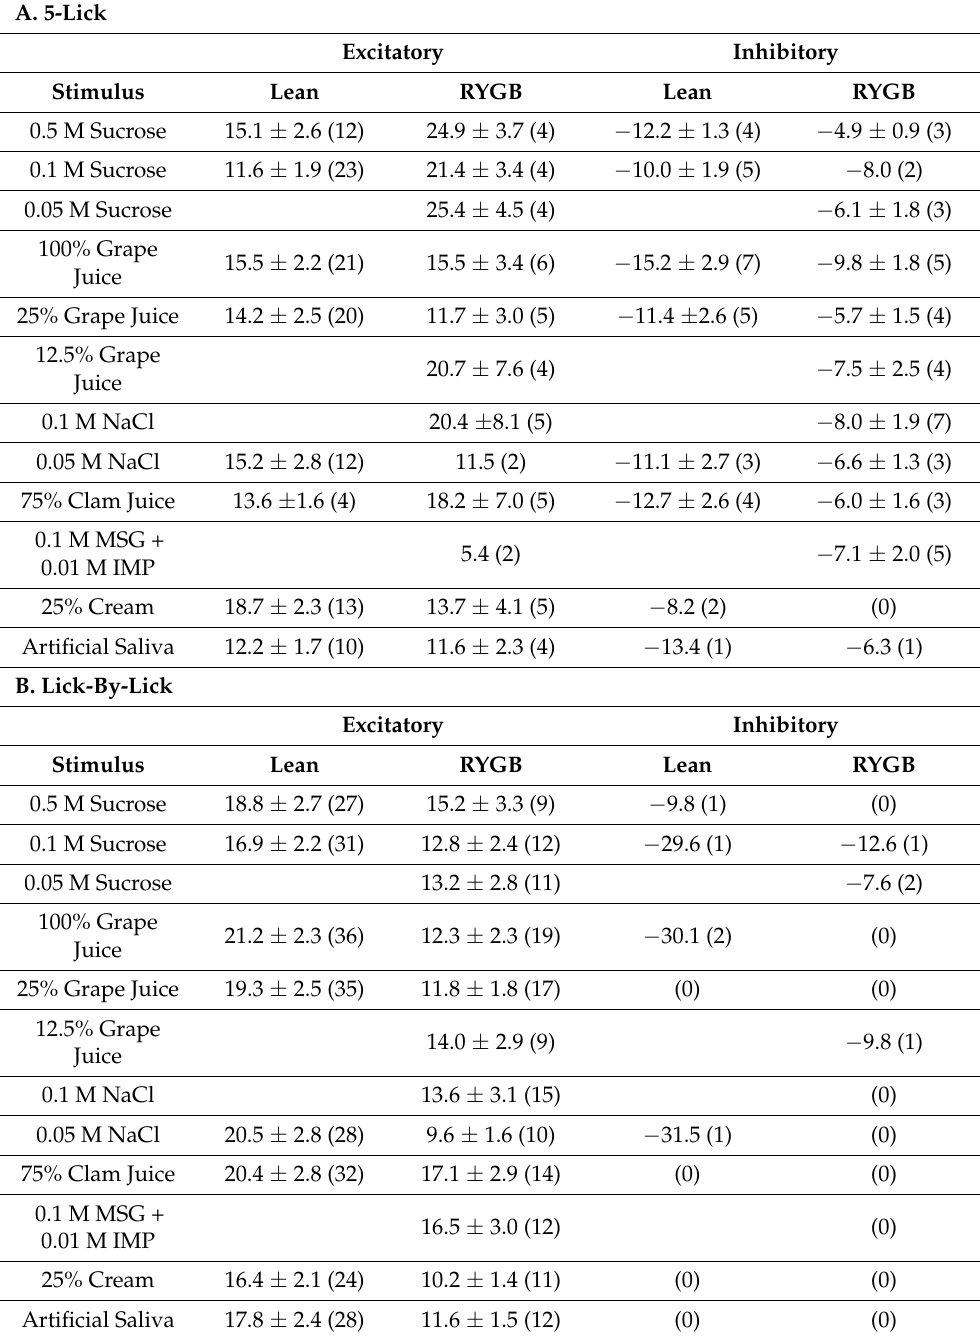
Table 2. NTS taste response magnitude in Lean and RYGB rats. Mean ± SEM ( N